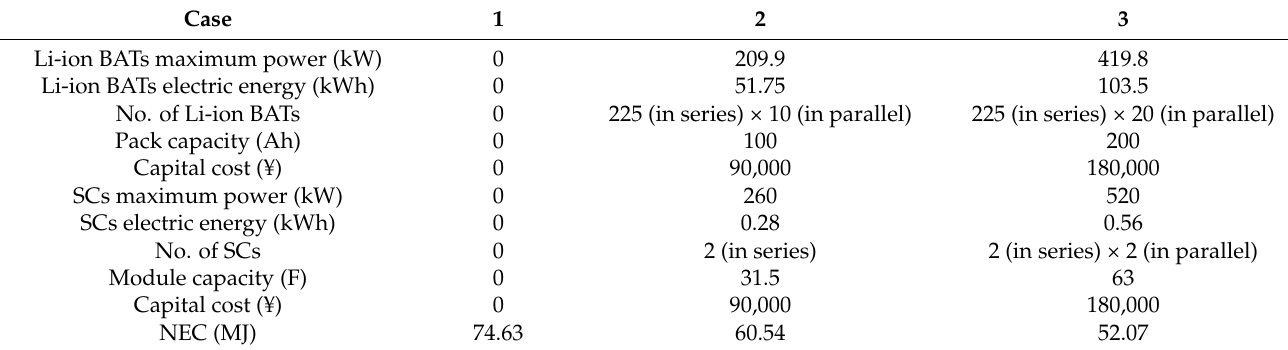
Table 5. The specific parameter and optimization results for cases